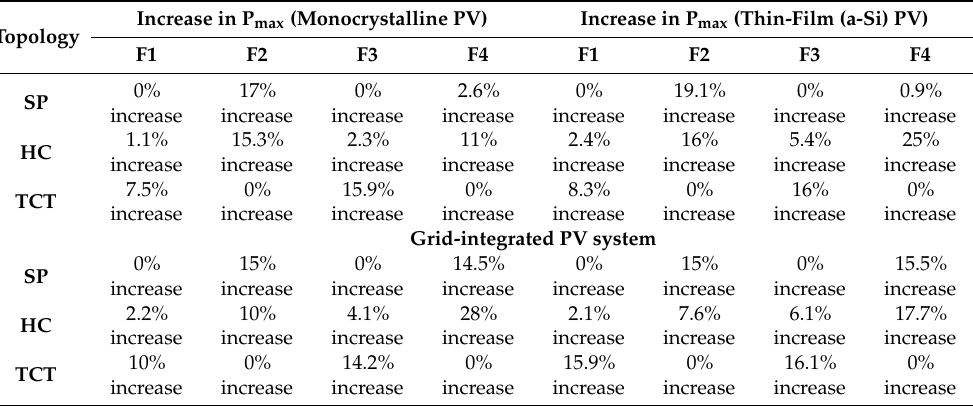
Table 11. Comparative analysis of results as represented in Table